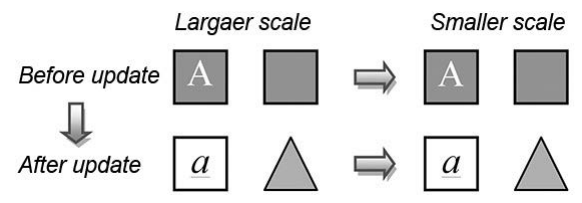
Fig. 4. Cases of updating features